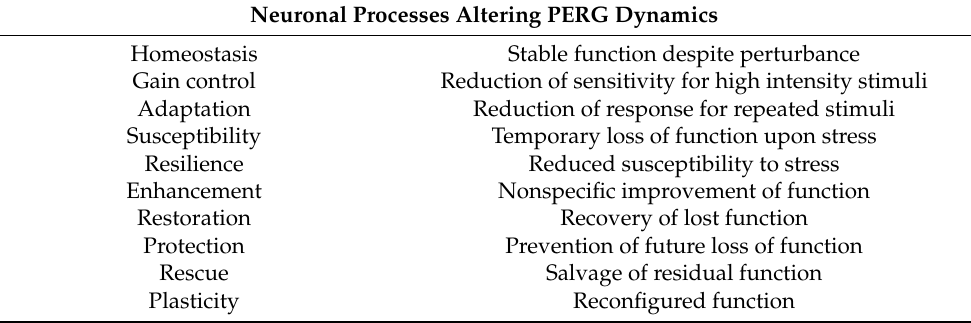
Table 2. Relevant attributes of RGC function that can be investigated with PERG dynamics before and after neuroprotective treatment.